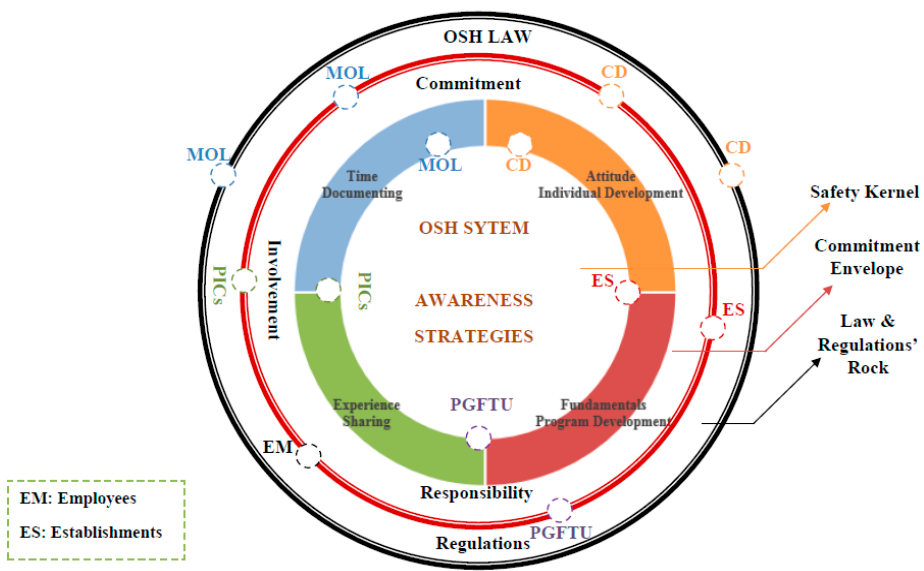
Figure 24. The layers and responsibilities in the safety system.